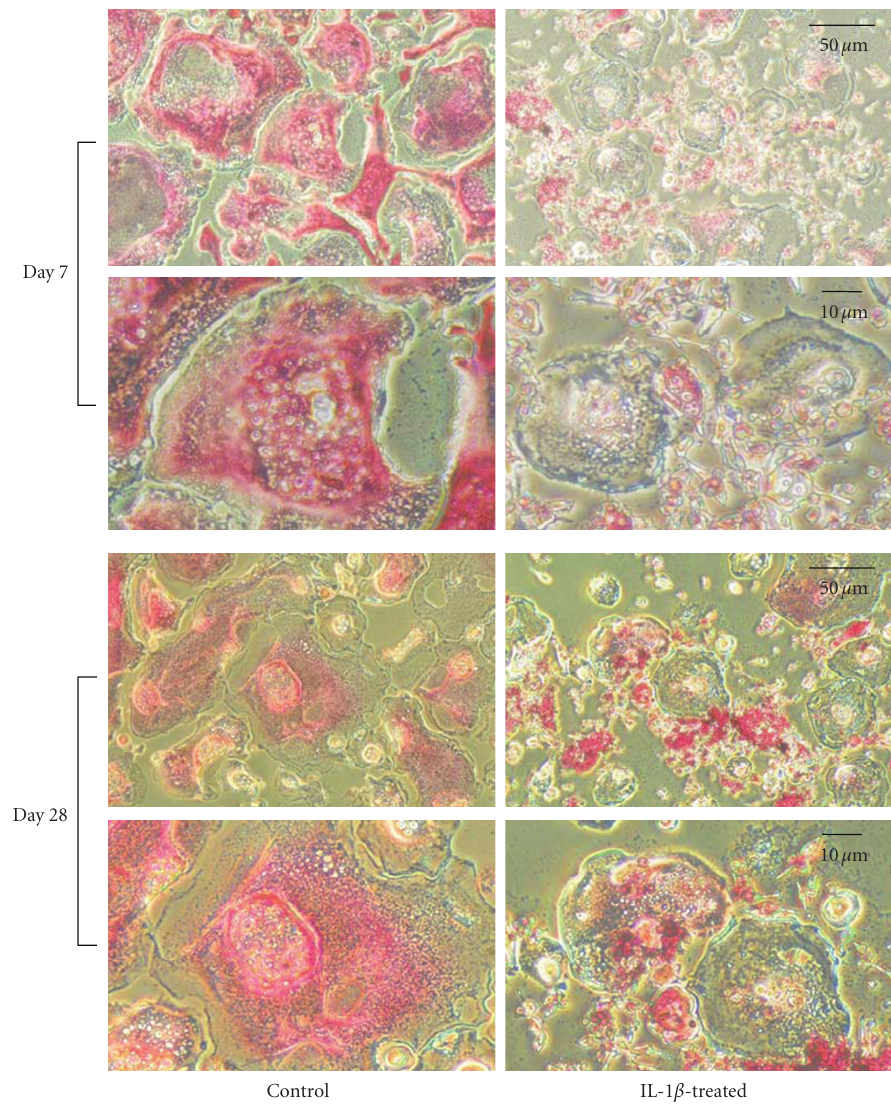
Figure 5: E ff ect of conditioned medium from IL-1 β -treated and -untreated chondrocytes on the formation of osteoclast-like cells. Cells were cultured in DMEM containing 10% FBS with or without 100 U/mL IL-1 β for 7 or 28 days. The culture medium was changed to DMEM containing 2% FBS without IL-1 β , and the cells were cultured for 24h. The culture medium was collected and diluted with an equal volume of DMEM containing 2% FBS, supplemented with 50ng/mL soluble RANKL, and then used as conditioned medium. RAW264.7 cells, an osteoclast precursor, were cultured in conditioned media from IL-1 β -treated and -untreated (control) chondrocytes for up to 7 days, and then stained using a TRAP and alkaline phosphatase double-staining